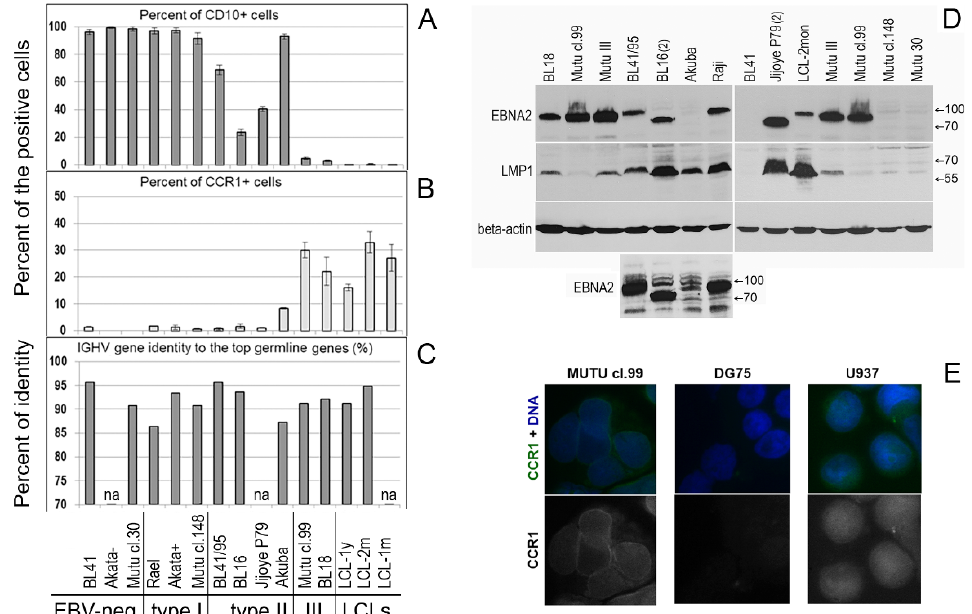
Figure 2. Phenotype of the Burkitt lymphoma cell lines. The percentages (%) of CD10-positive ( A ) and CCR1-expressing ( B ) cells were obtained using flow cytometry analysis. Annexin V-stained (apoptotic) and autofluorescent cells were omitted from the analysis. The presented data are from at least two independent experiments and are shown as the mean with the SD. ( C ) The IGHV gene identity (%) to the top germline genes was defined using the NCBI IGBLAST Tool. ( D ) EBNA2 and LMP1 protein expression in the type II and type III BL cell lines was assessed using immunoblotting of cell lysates and specific antibodies; the human beta-actin protein was probed as the loading control. The Raji and Mutu III BL type II cell lines served as the positive control (Table S1). All clones of the Mutu cell line are derivatives of an early-passage BL cell line [14]. BL41 is an EBV-negative cell line. A small panel, the same immunoblot with prolonged exposure, shows the EBNA2 protein in the cell lines BL41/95, BL16, Akuba, and Raji. ( E ) Immunofluorescent staining of CCR1 is shown in cells of the type III BL cell line Mutu cl.99 and human myeloid histiocytic lymphoma cell line U937, used as the positive control; in DG75, the EBV and the CCR1 transcript negative BL cell line, the CCR1 immunofluorescent signal was not observed.